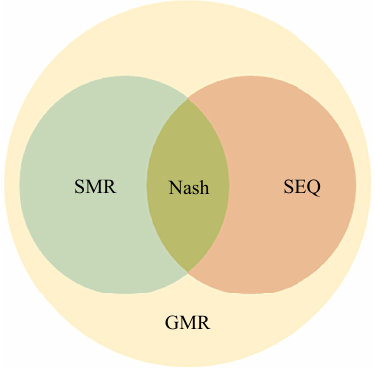
Figure 2. The interrelationships of four stabilities (Nash, GMR, SMR, and